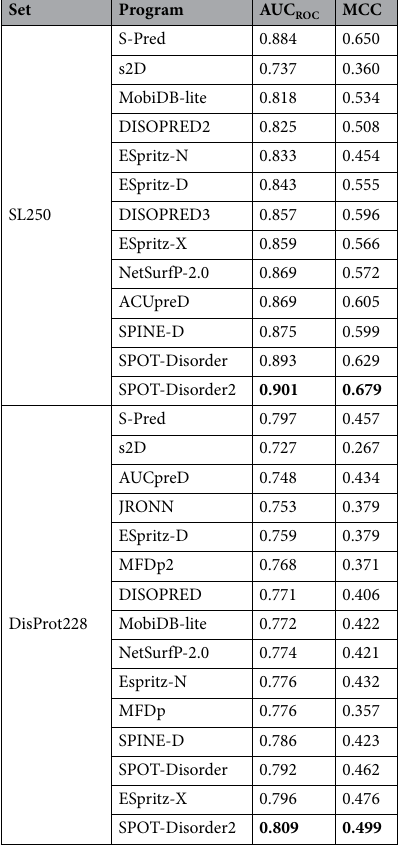
Table 5. Comparison of IDR predictions by several methods. The AUC ROC and MCC metrics for methods other than S-Pred were obtained from the study conducted by Hanson et al. 10 . For the DisProt228 dataset, only sequence-profile-based methods are presented. The method that performs the best is represented in